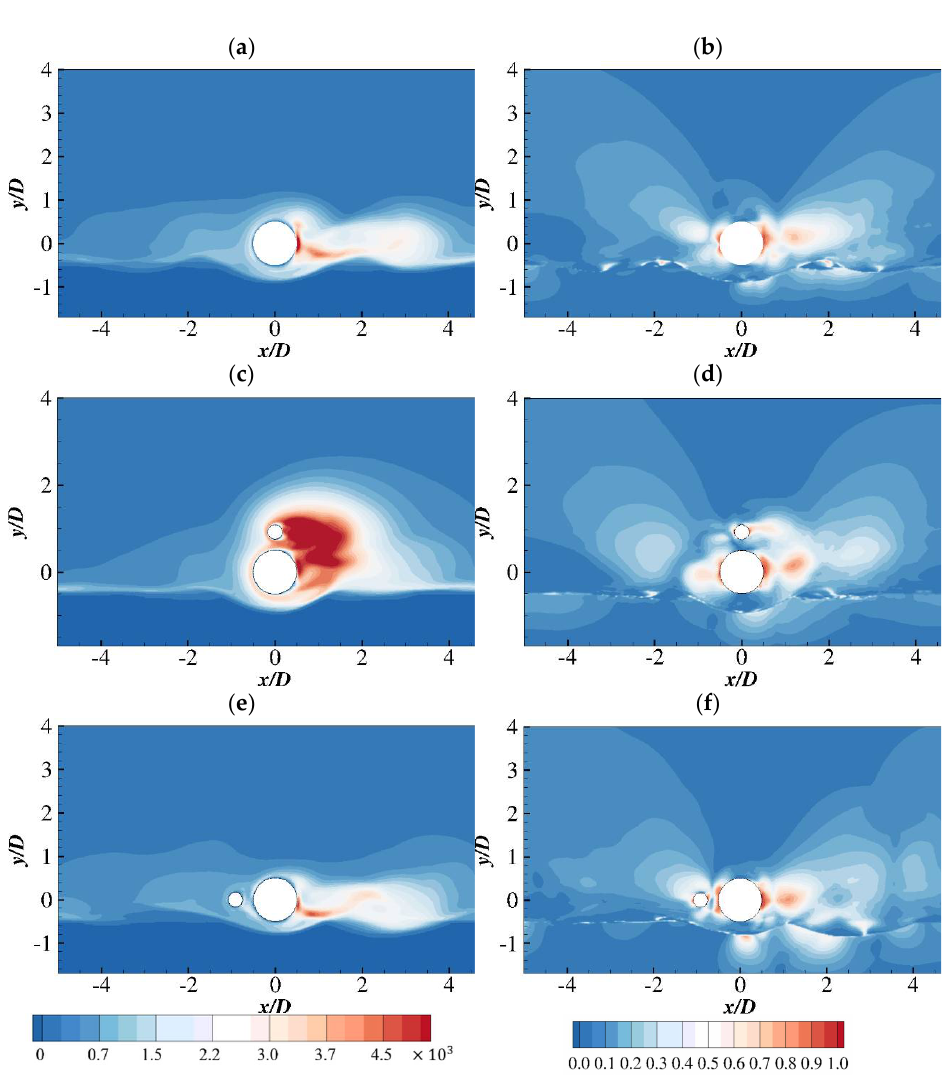
Figure 9. ( a , c , e ) The phase-averaged contours of the TKE k f ( m 2 / s 2 ) and ( b , d , f ) the value of v f 2 /2 K f Figure 9. ( a ), ( c ), ( e ) The phase-averaged contours of the TKE (cid:1863) (cid:3033) ( (cid:1865) (cid:2870) /(cid:1871) (cid:2870) ) and ( b ), ( d ), ( f ) the value at the phase of T w of (cid:1874) (cid:3033)(cid:2870) /2(cid:1837) (cid:3033) at the phase of (cid:1846) (cid:3050) /2 .